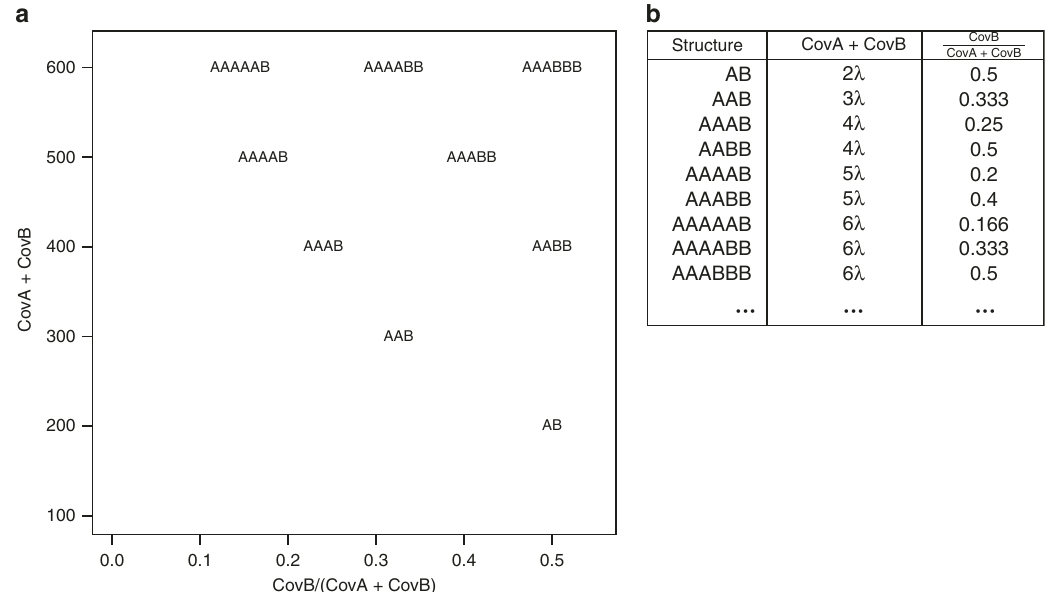
Fig. 7 Smudgeplot genomic structure locations. Coordinates of individual genomic structures for a genome with monoploid coverage = 100 in a 2D space of coverage sums versus coverage ratios and in b a table of coordinates.